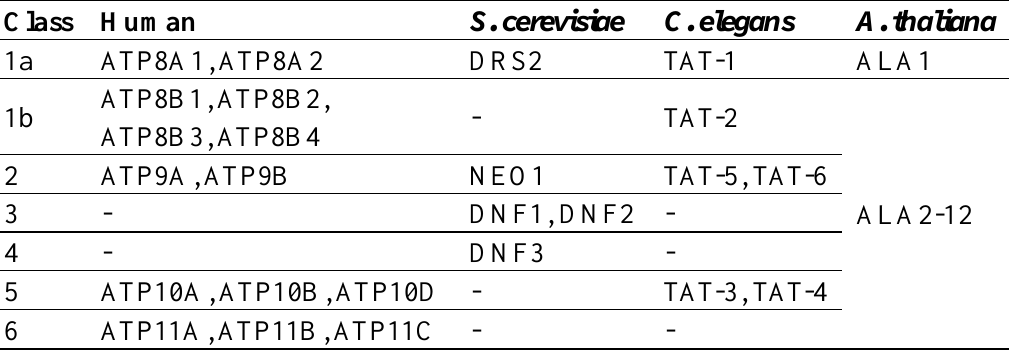
Table 1. P4-ATpases in human, yeast, worm and